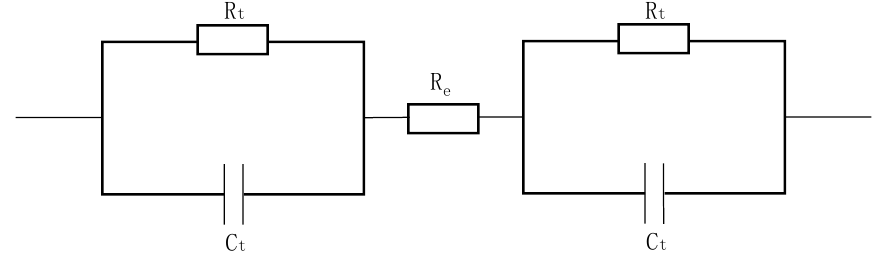
Figure 4. Equivalent circuit of fabric electrodes for testing AC impedance. Equation (5) is obtained based on Equations (2)–(4), which provide the expressions for resistance, capacitance, and AC impedance.